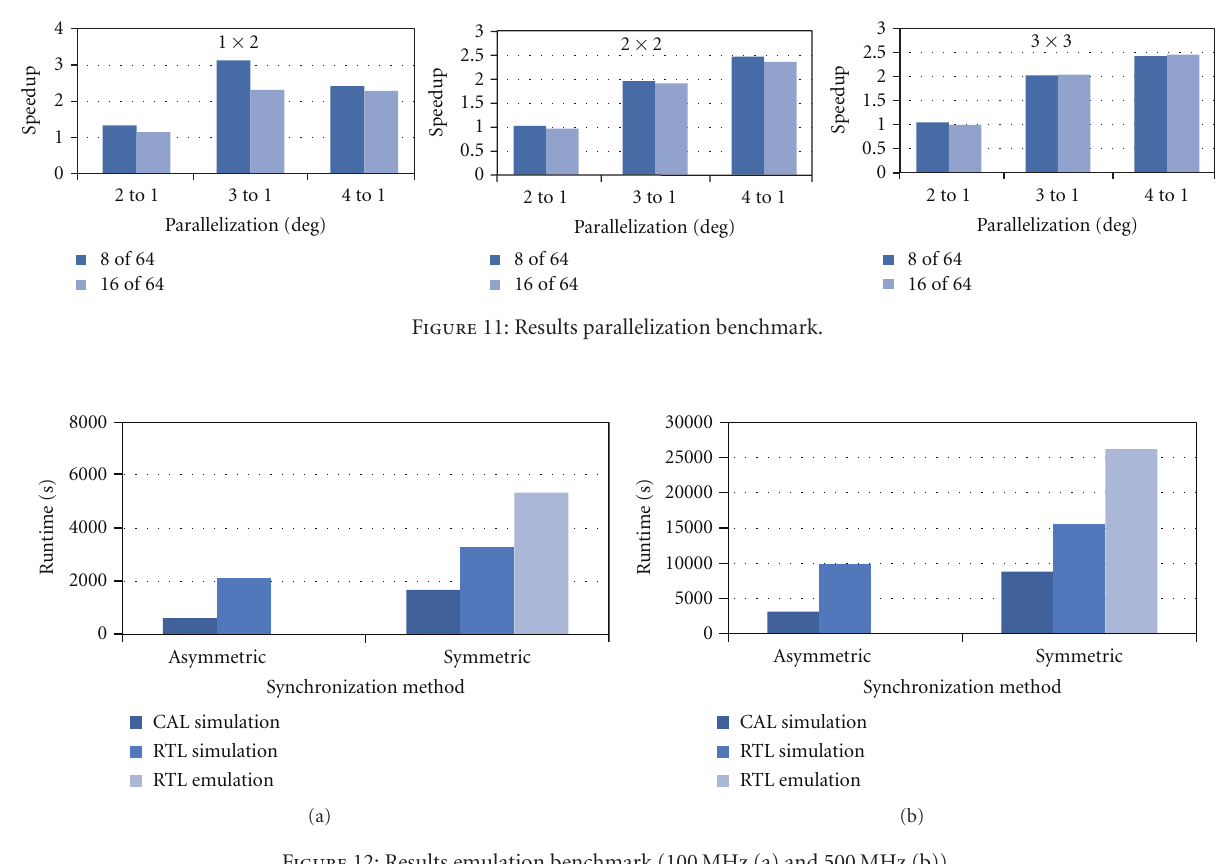
Figure 12: Results emulation benchmark (100 MHz (a) and 500 MHz (b)).